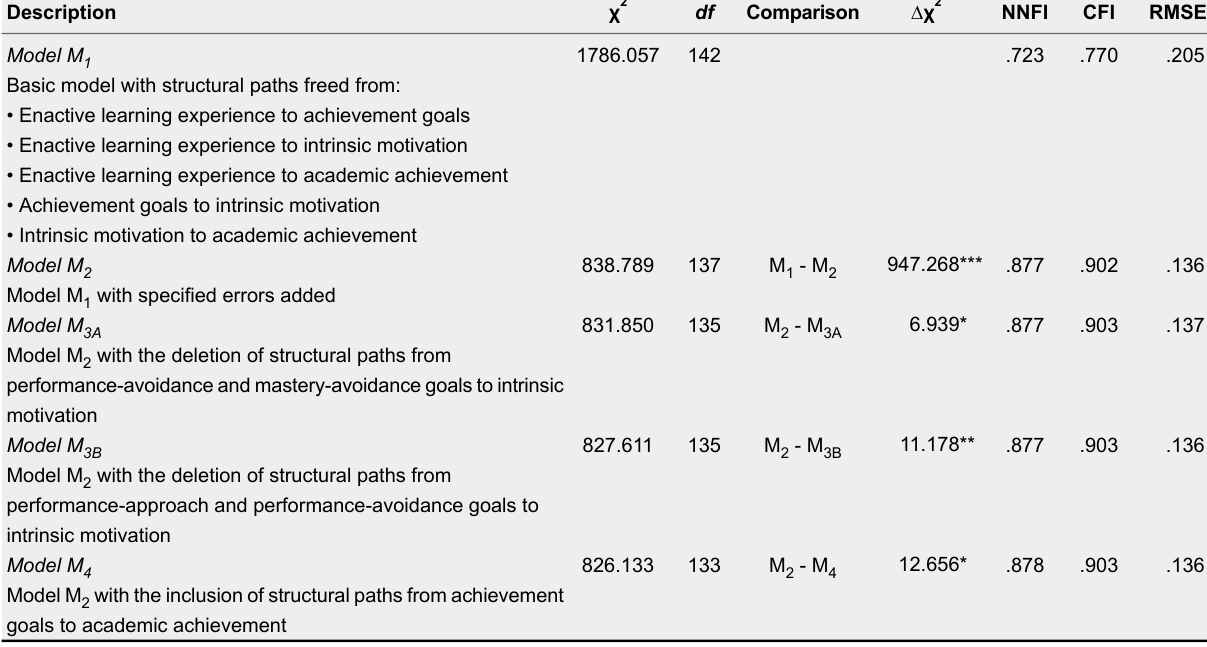
Goodness-of-fit Index Values for a Priori Models